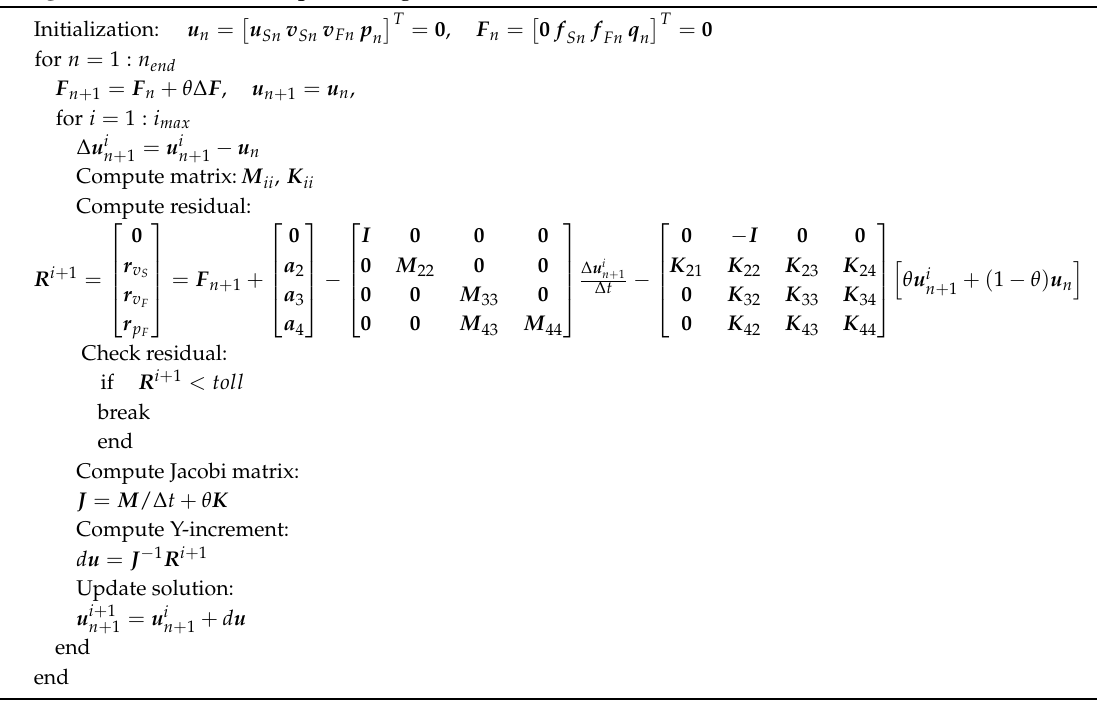
Algorithm 1: Newton–Raphson